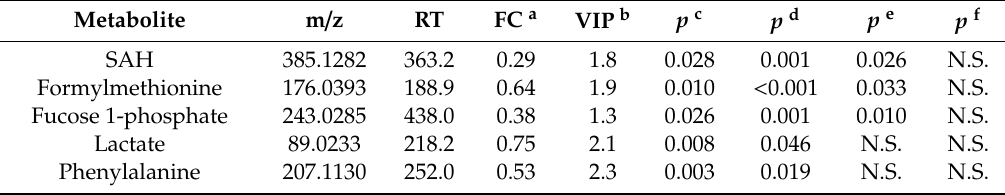
Table 1. Potential metabolic biomarkers discriminate LCCs from RCCs at stage I.